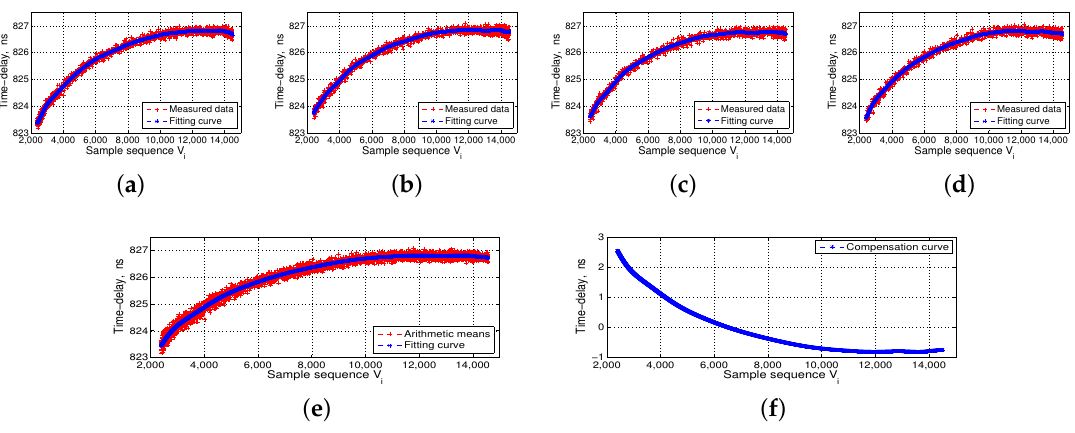
Figure 10. RF channel reception-delay measurement data preprocessing. ( a – d ) the reception-delay data measured four times and the corresponding fitting curves; ( e ) the arithmetic means of the delay data measured four times and the corresponding fitting curves; and ( f ) the final reception-delay compensation curves of the RF